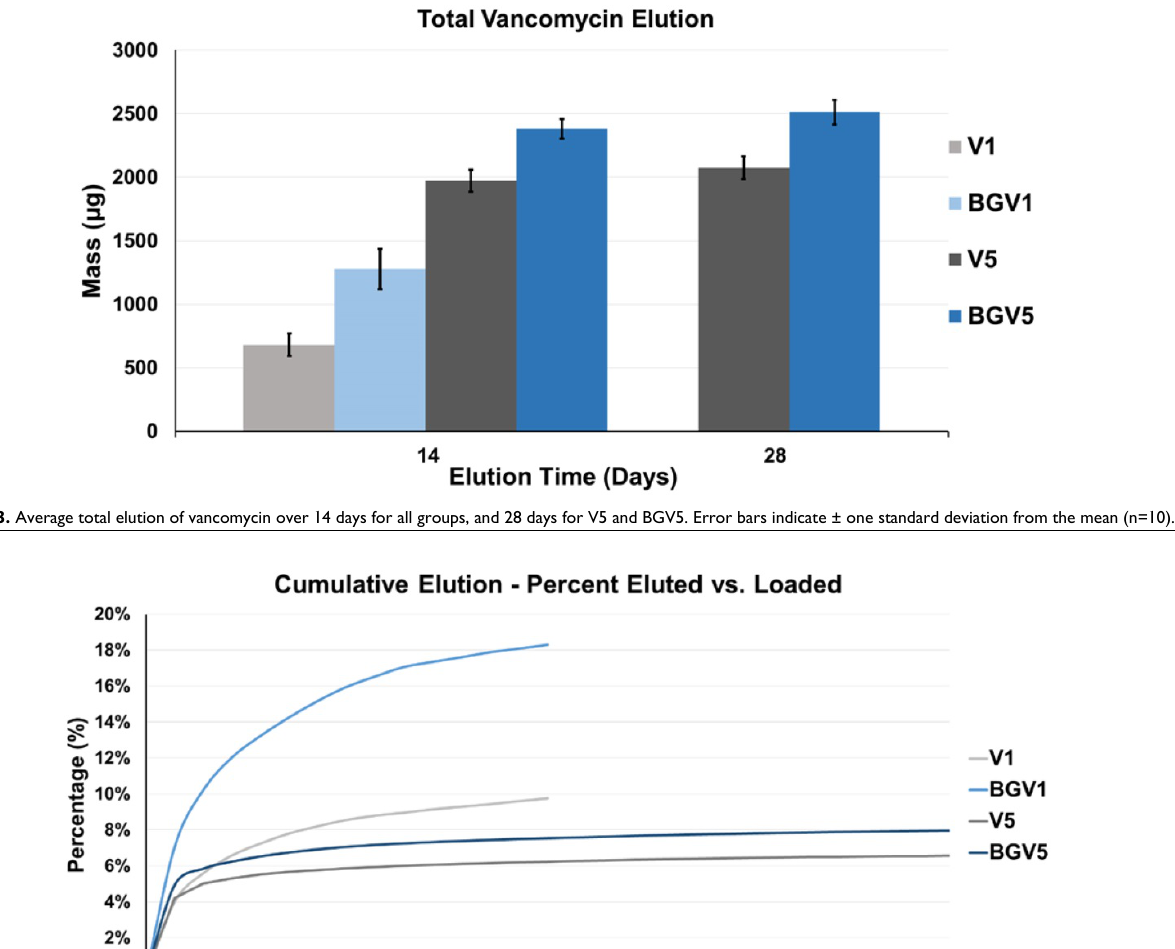
http://www.jbji.net